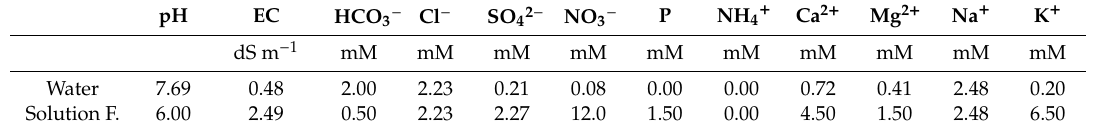
Table 1. Composition of irrigation water (Water) and fertigation solution (Solution